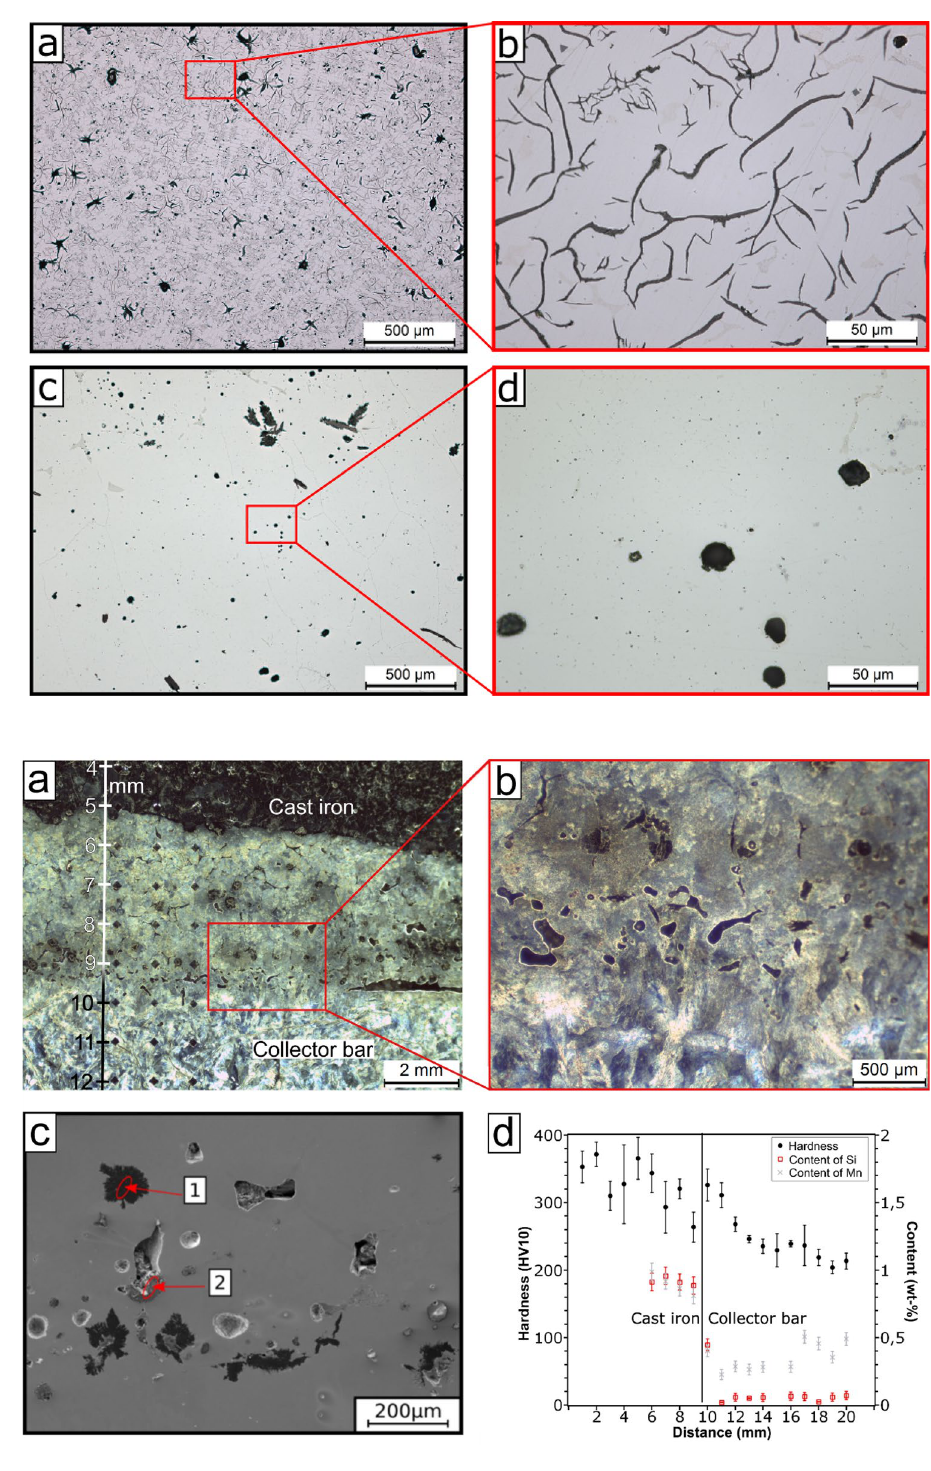
Fig. 5 Interface of cast iron and collector bar ( a , b ). The SEM image ( c ) marks two types of inclusions. Correspond- ing hardness and EDS-scans 10 mm from the interface in each direction are additionally